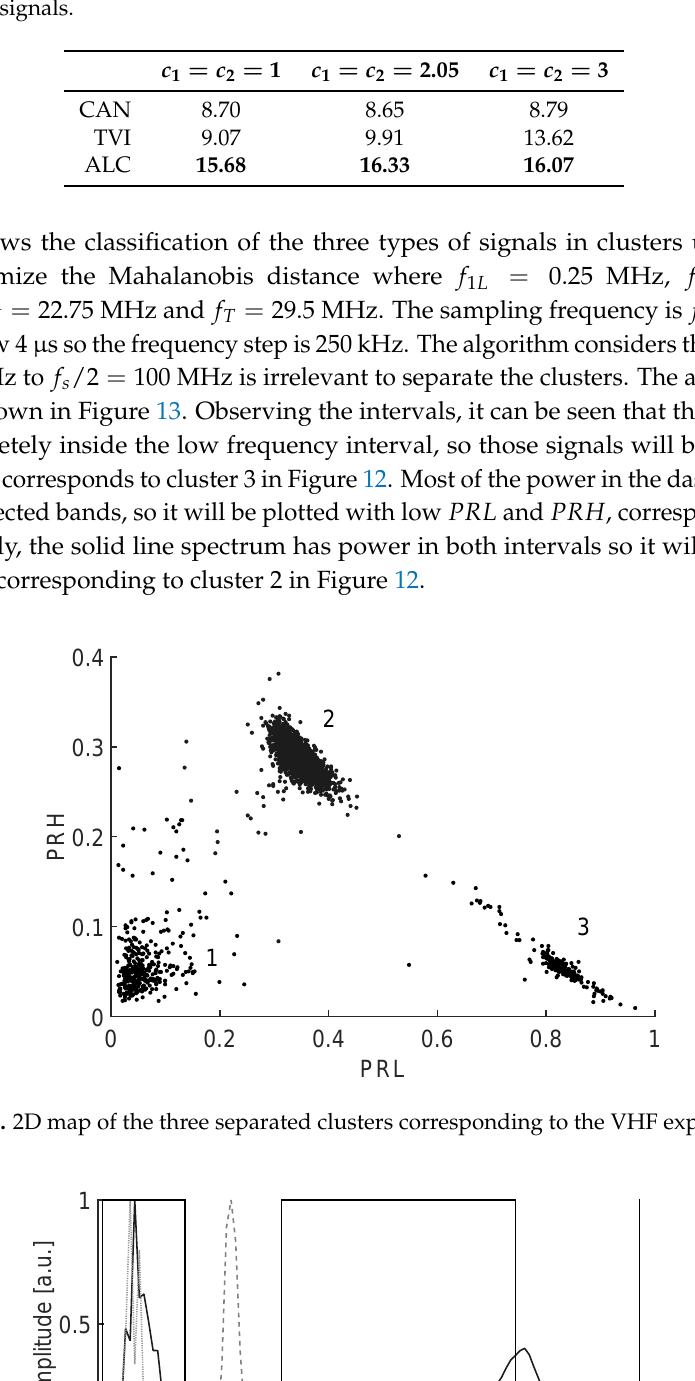
Table 3. Minima of the maxima Mahalanobis distances achieved with Canonical PSO (CAN), time varying inertia PSO (TVI) and ageing leader and challengers PSO (ALC) for the experiment with very high frequency signals.